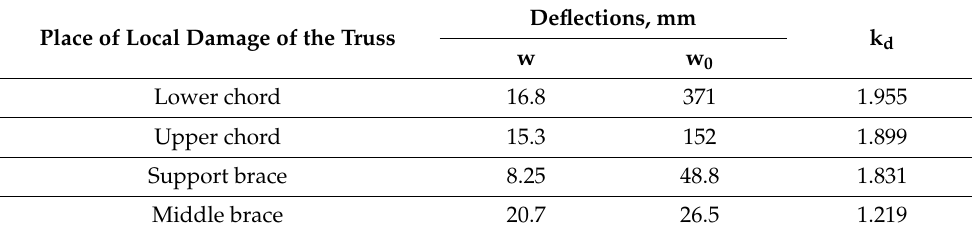
Table 1. Theoretical dynamic coefficients for a truss with a span of 24 m.